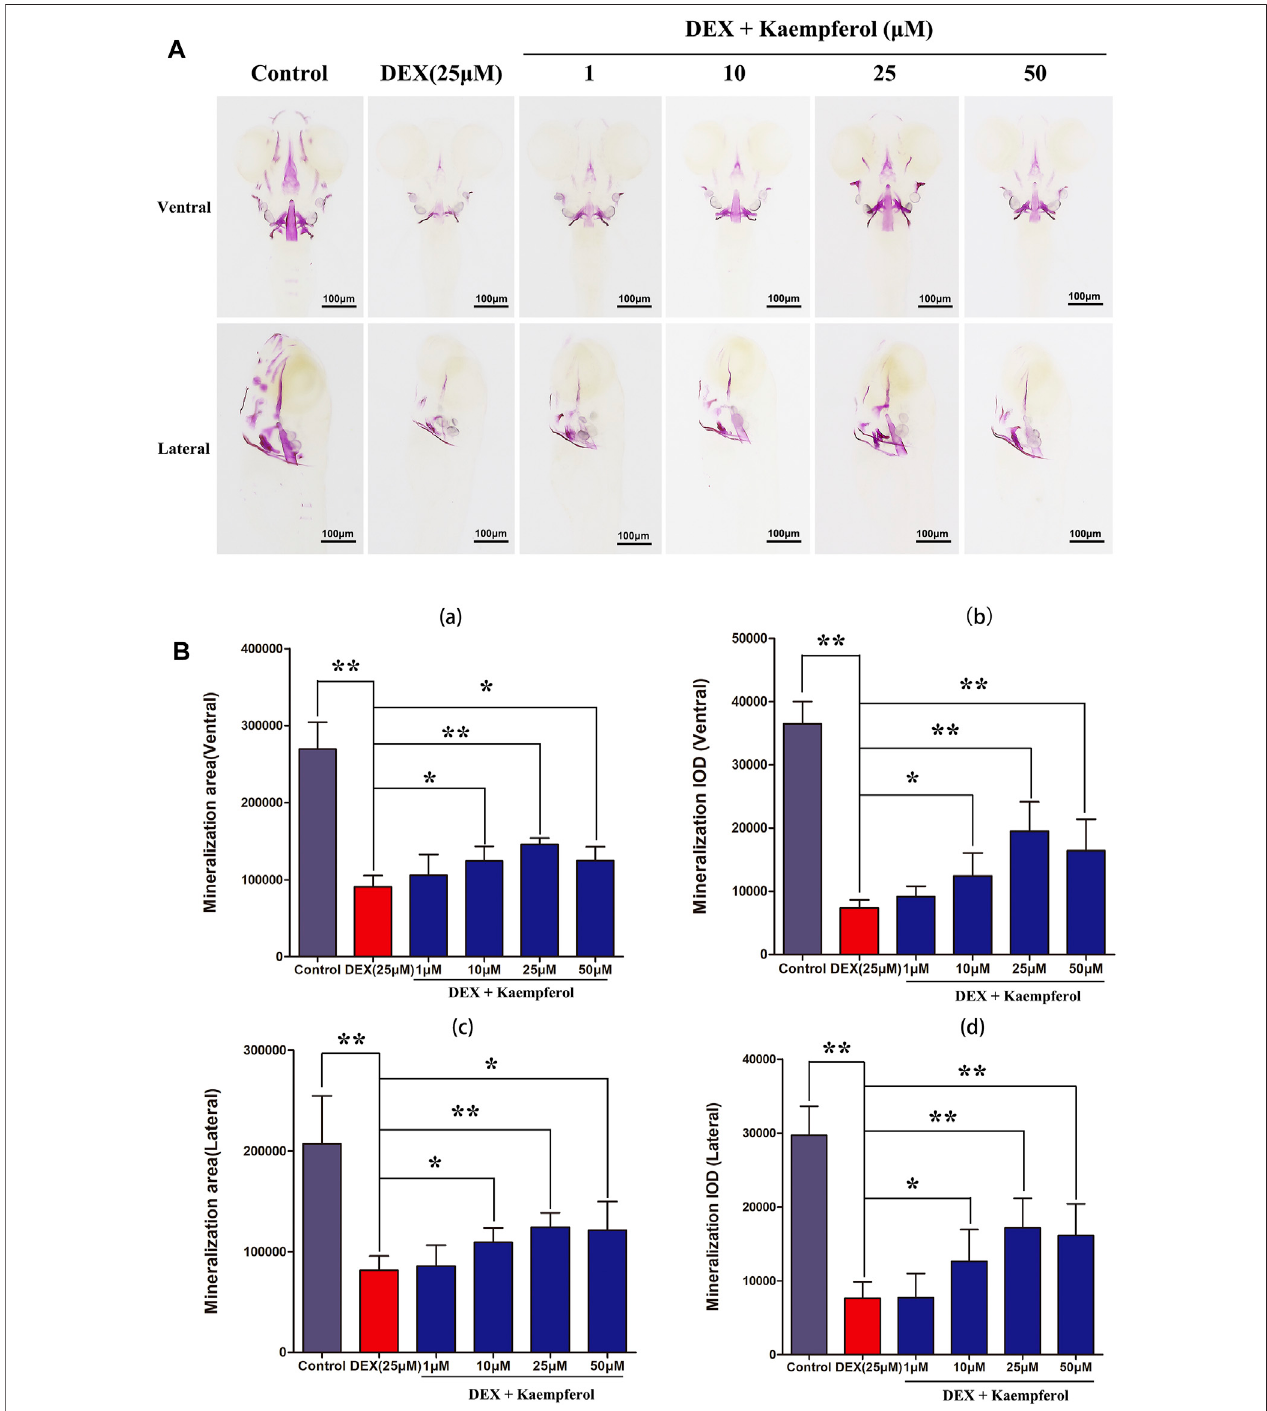
FIGURE 10 | kaempferol attenuated DEX-induced lessen of skull mineralization in zebra fi sh larvae. (A) Zebra fi sh larvae in control group, DEX group and DEX + kaempferol(1,10,25and50 μ M))groupwerestainedwithalizarinredtoevaluatethedegreeofskullmineralization. (B) TheareaandIODofskullalizarinredstainingwere analyzedbyIPP. (a) ventralareaofskullmineralization, (b) ventralskullmineralizationofIOD, (c) lateralareaofskullmineralization, (d) lateralskullmineralizationofIOD.* p < 0.05 , ** p < 0.01.